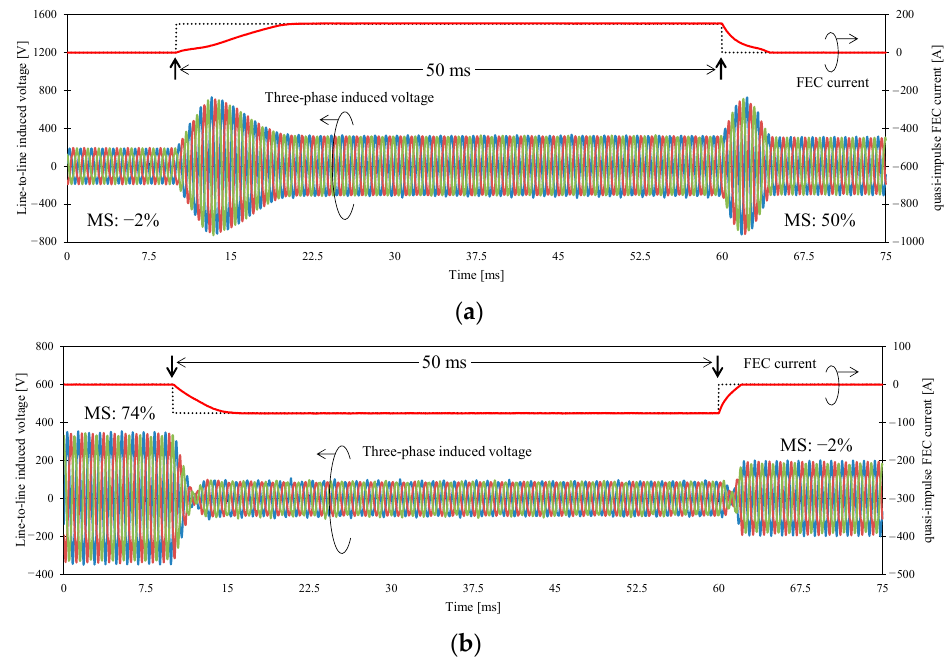
Figure 11. Measured FEC current waveforms for changing MS of VM-PM. ( a ) magnetization state change from − 2% to +50%; ( b ) magnetization state change from +74% to − 2%.